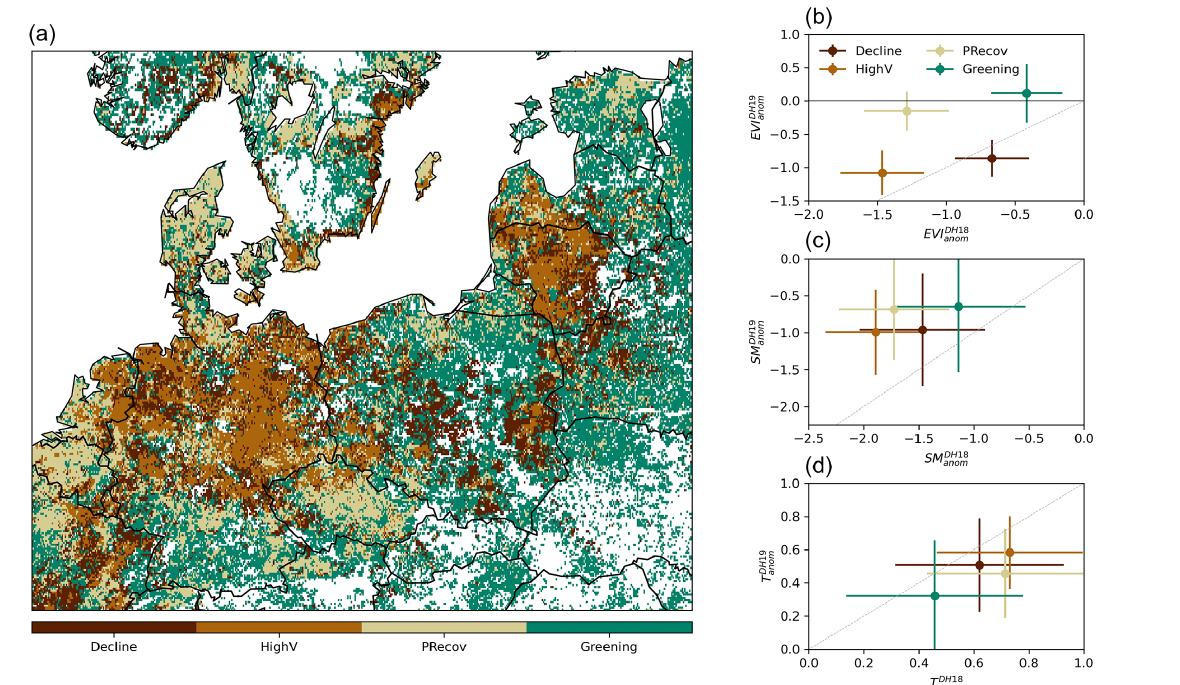
Figure 3. Classification of impact groups within the study region in central Europe. Panel (a) shows the spatial distribution of the four clusters from unsupervised classification of (EVI DH18 anom , EVI DH19 anom ) values. The corresponding (EVI DH18 anom , EVI DH19 anom ) distribution in each cluster is indicated in panel (b) (circles indicate the spatial mean and lines the spatial standard deviation within each cluster). The corresponding distributions of SM anom and T anom pairs are shown in panels (c) and (d) , respectively. The grey line indicates similar anomalies in the two DH events. Only pixels with negative EVI DH18 anom are